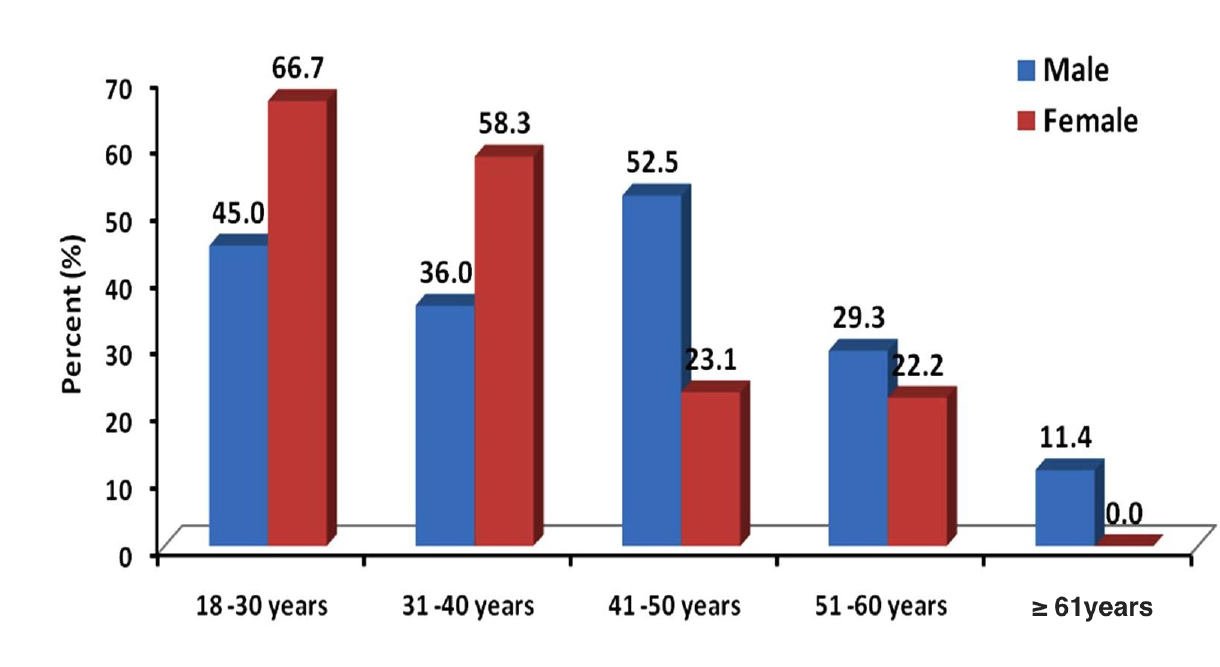
Figure 2. Distribution frequency of health information seekers among diabetic patients by age and